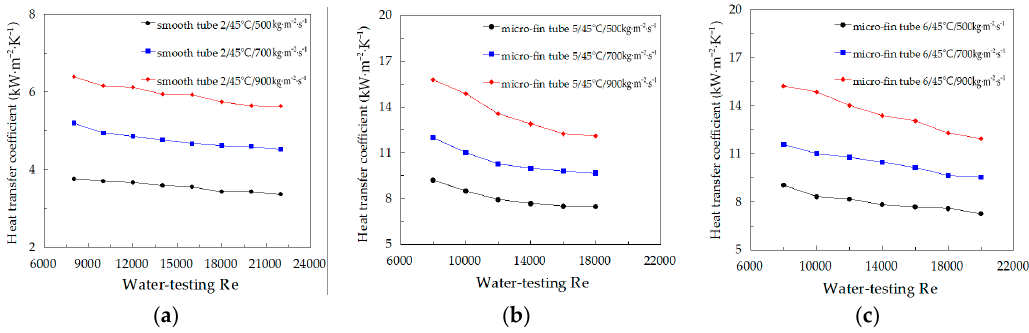
Figure 8. Influence of water-testing Reynolds number on the heat transfer coefficient inside ( a ) tubes 2; ( b ) 5 and ( c ) 6 for R134a.